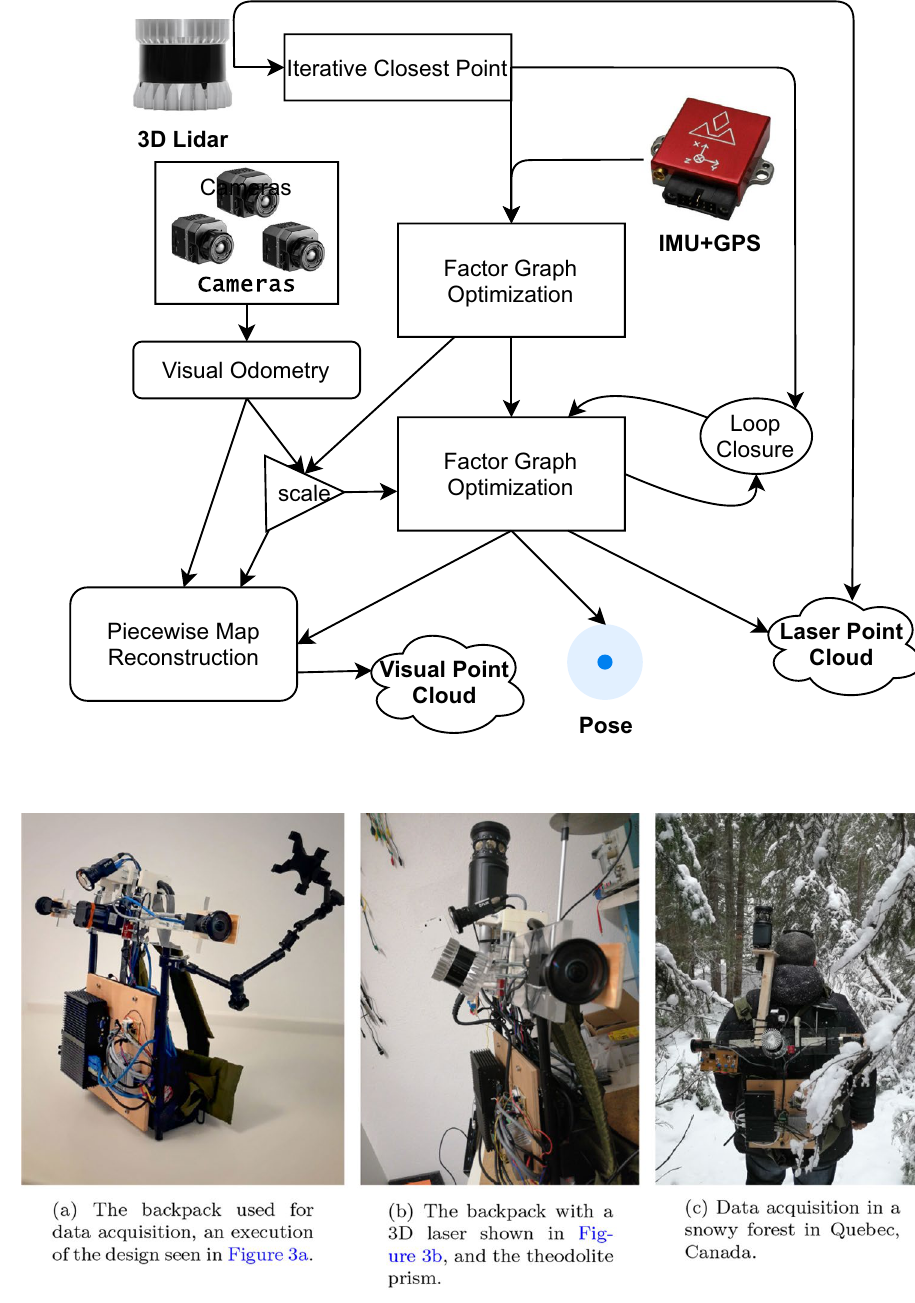
Fig. 1 Flow chart of the proposed framework, includ- ing the sensors used during experimentation